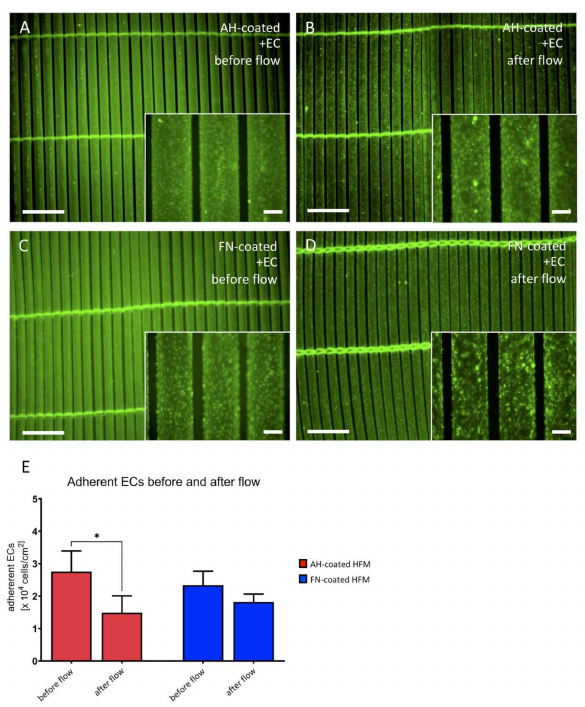
Figure 7. Assessment of EC monolayer after flow exposure. Labeled EC monolayers ( green ) on AH ( A , B ) or FN coated HFM ( C , D ) were assessed before ( A , C ) and after ( B , D ) flow exposure (lower magnification images ( A – D ) scale: 1.5 mm, inserted box ( A – D ): enlarged area of respective EC monolayer areas; Scale: 200 µ m). ( E ) Quantification of adherent ECs on AH and FN coated HFM before and after flow